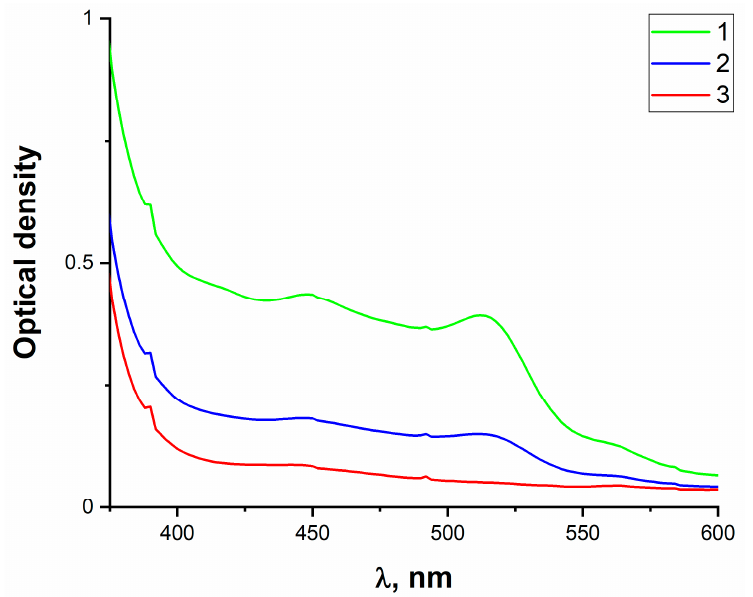
Figure 12. Reaction of CoAcr 2 PhTpy with HCl: 1—initial complex, 2—addition of 1 drop of HCl, 3—addition of 2 drops of HCl.